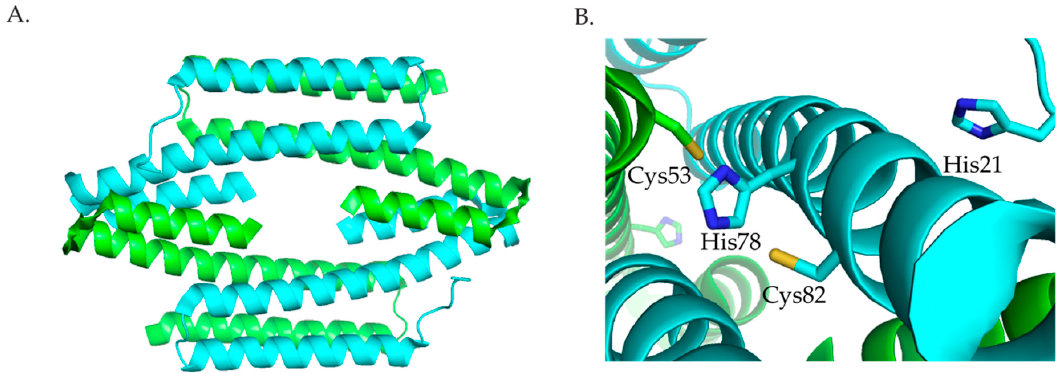
Figure 5. ( A ) The crystal structure of Synechocystis PCC6803 InrS (PDB ID 5FMN) [64]. The